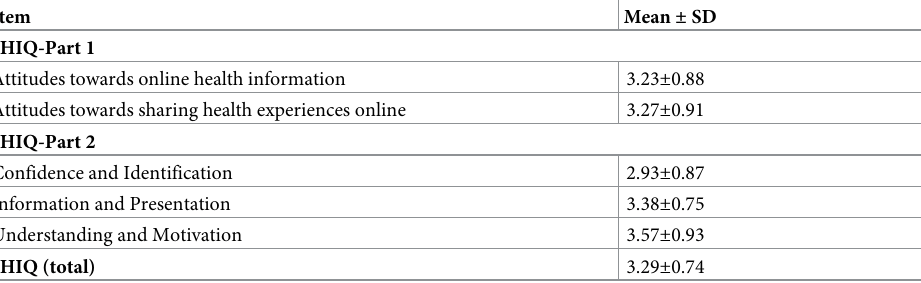
Table 1. Online health information seeking scores of the